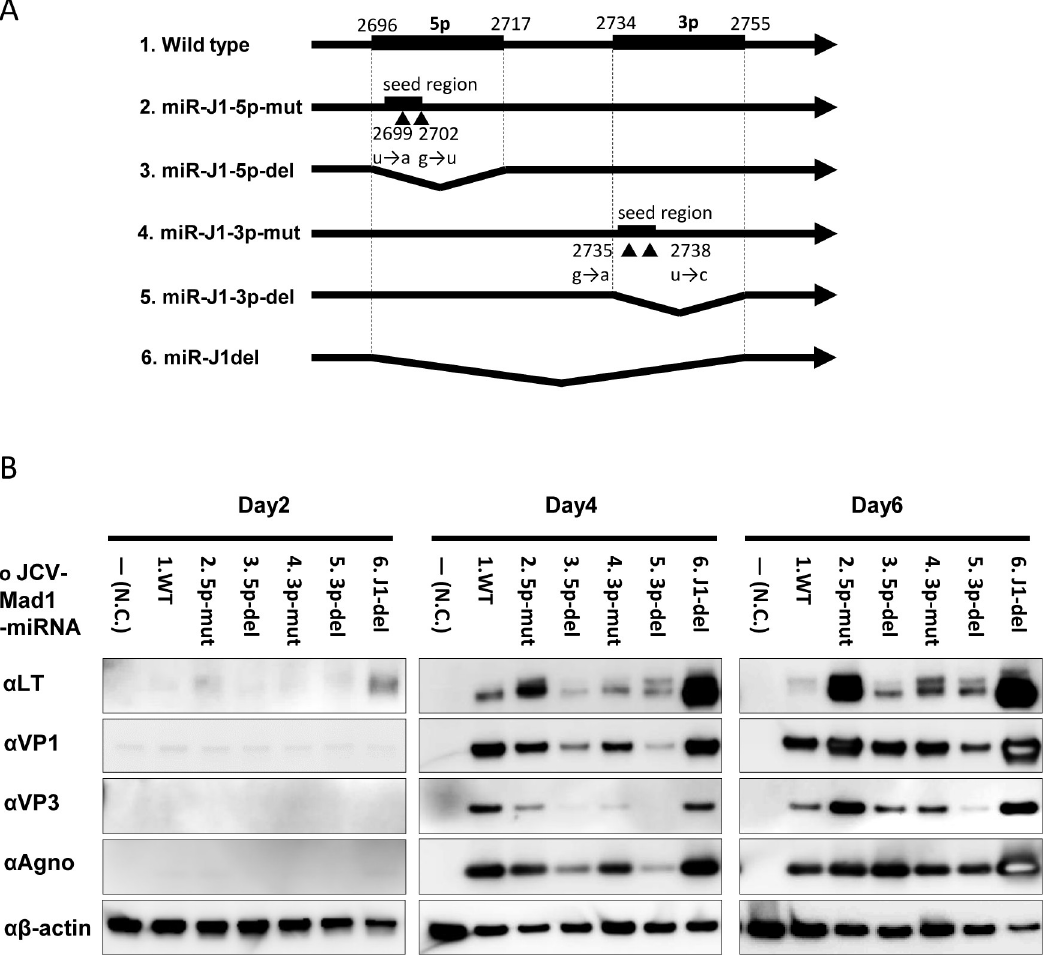
Fig 5. JCPyV replication in miR-J1-mutants. (A) Construction of JCPyV mutants. Point or deletion mutants were constructed in pre-miR-J1 of the JCPyV genome. (B) Western blot analysis on lysates of mutant-transfected IMR32 cells. Each number (1–6) corresponds to that in (A). The results from samples taken on day 2, 4, and 6 post-transfection are